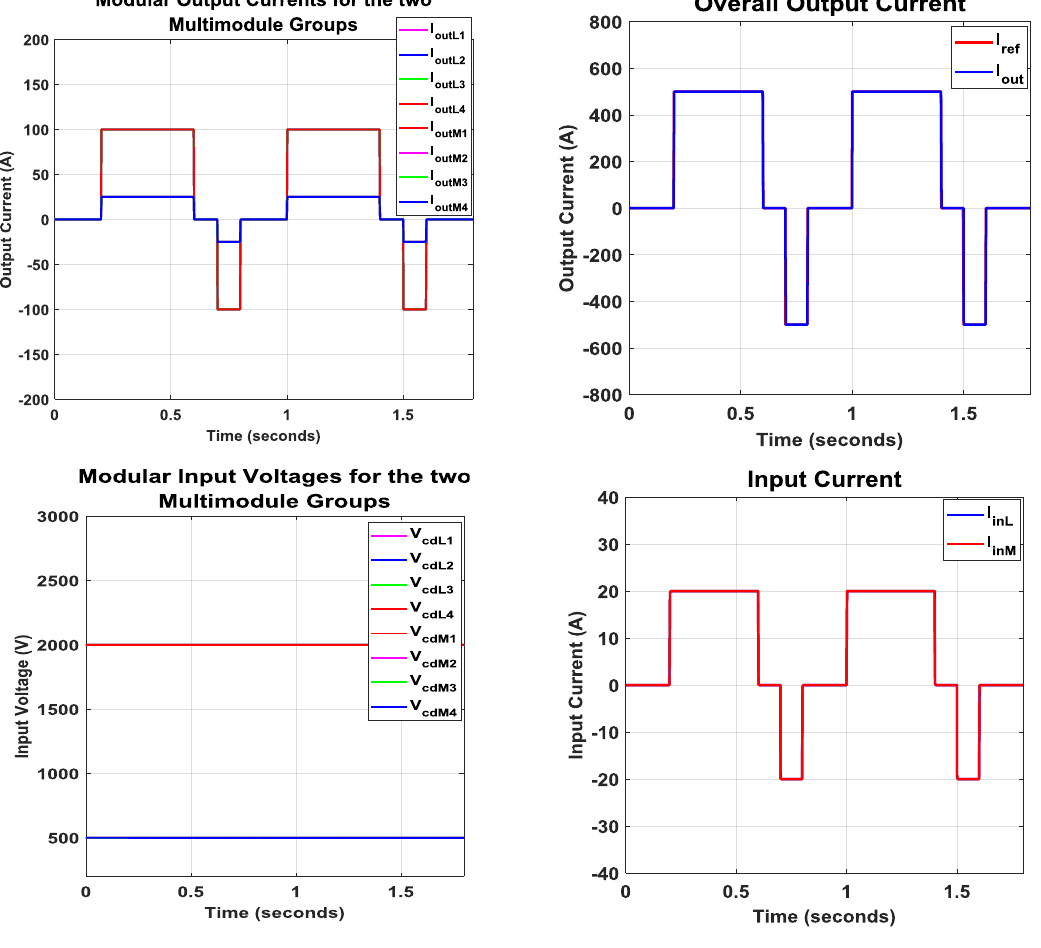
Figure 11. Simulation results for the eight-module hybrid ISOP system.